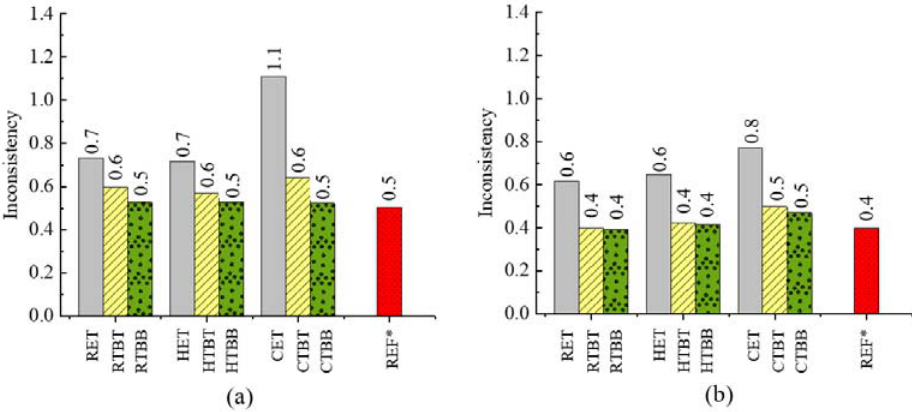
Figure 16. Flight inconsistency comparison of ( a ) pitch and ( b ) roll angles using different tank setups. Here, REF* is without tank inconsistency.